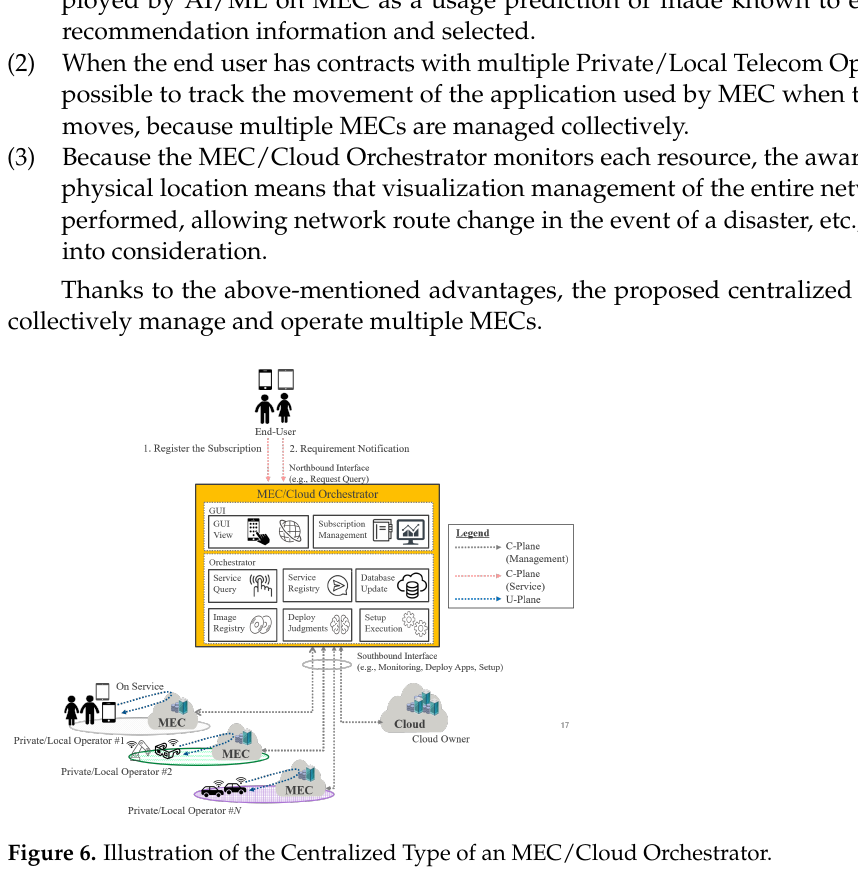
Figure 6. Illustration of the Centralized Type of an MEC/Cloud